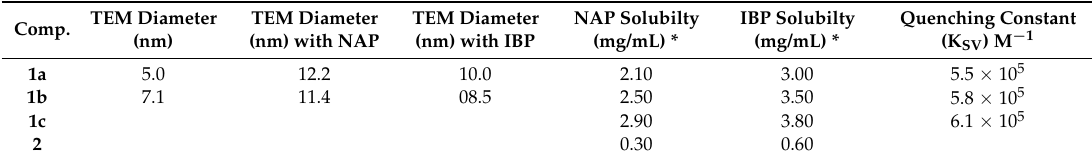
Table 1. Transmission electron microscopy (TEM) of 1a , b with and without NAP and IBP; solubility of NAP and IBP in aqueous solution of 1a – c ; quenching constant (K SV ). Comp. TEM Diameter (nm)